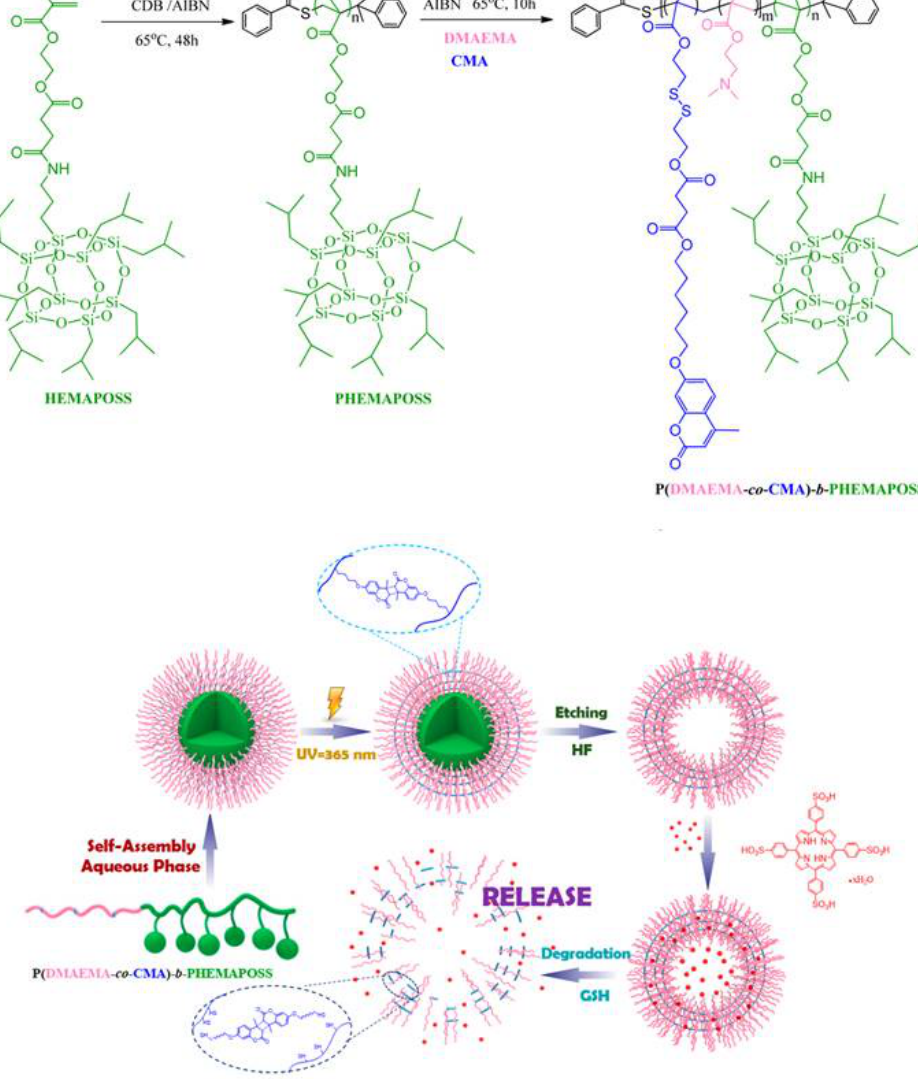
Figure 14. Schematic illustration of the synthesis of the PHEMAPOSS- b -P(DMAEMA- co -CMA) block copolymer and structural changes of polymeric capsules in the process of loading and release of TPPS. Reprinted with permission from [127]. Copyright (2016) American Chemical Society.